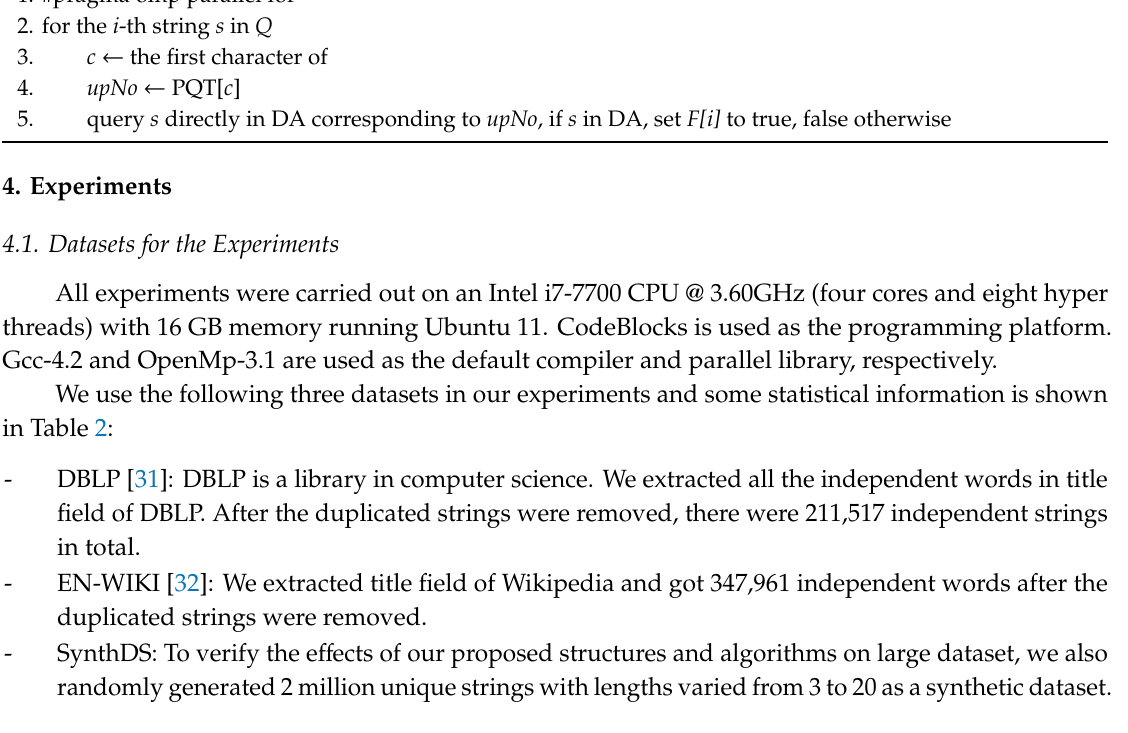
Table 2. Statistical information of the three